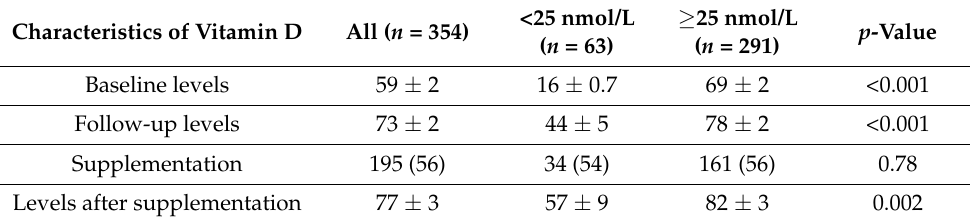
Table 5. Vitamin D characteristics according to the deficiency